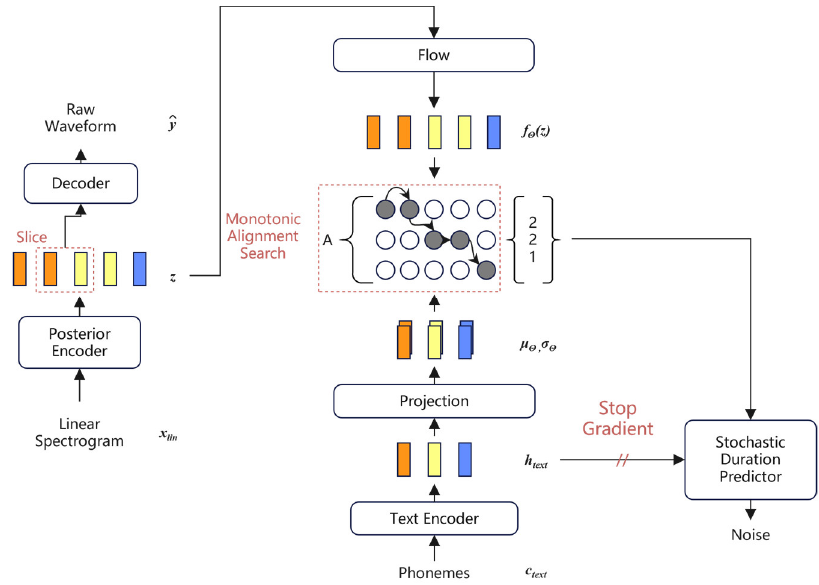
Figure 1. Training procedure of VITS. The slices of different colors represent different text embedding, and the number of slices of the same color represents the duration.